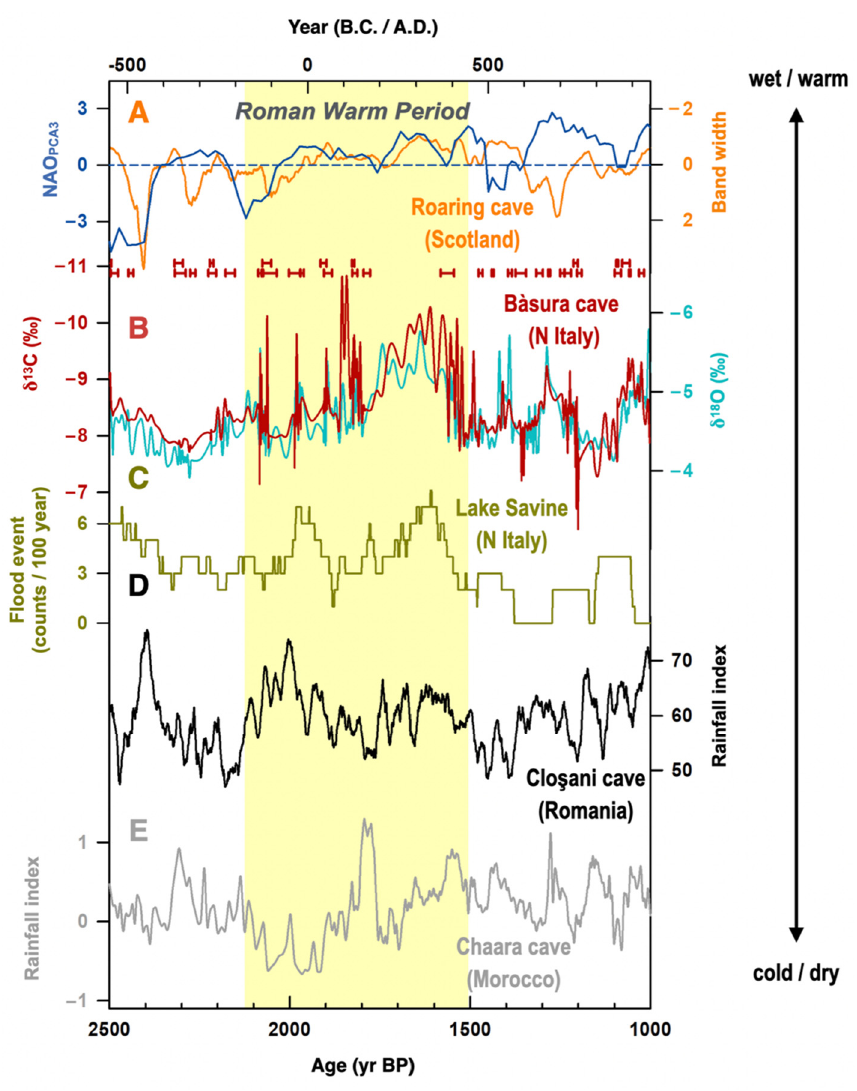
Figure 2. Proxy-inferred hydroclimate records during the Roman warm period. ( A ) Stalagmite band-width records from Roaring cave (orange, [22]) and a paleo North Atlantic Oscillation (NAO) index reconstructed from Greenland (blue, [33]). ( B ) BA14-1 δ 13 C (dark red) and δ 18 O (tiffany blue). Horizontal error bars indicate U-Th ages with 2-sigma errors. ( C ) A flood event record from Lake Savine [23]. ( D ) Stalagmite-based precipitation index from Clo¸sani cave [24]. ( E ) Stalagmite-based precipitation index from Chaara cave [28]. The yellow bar indicates the interval of the Roman Warm Period from 200 B.C. to 400 A.D.